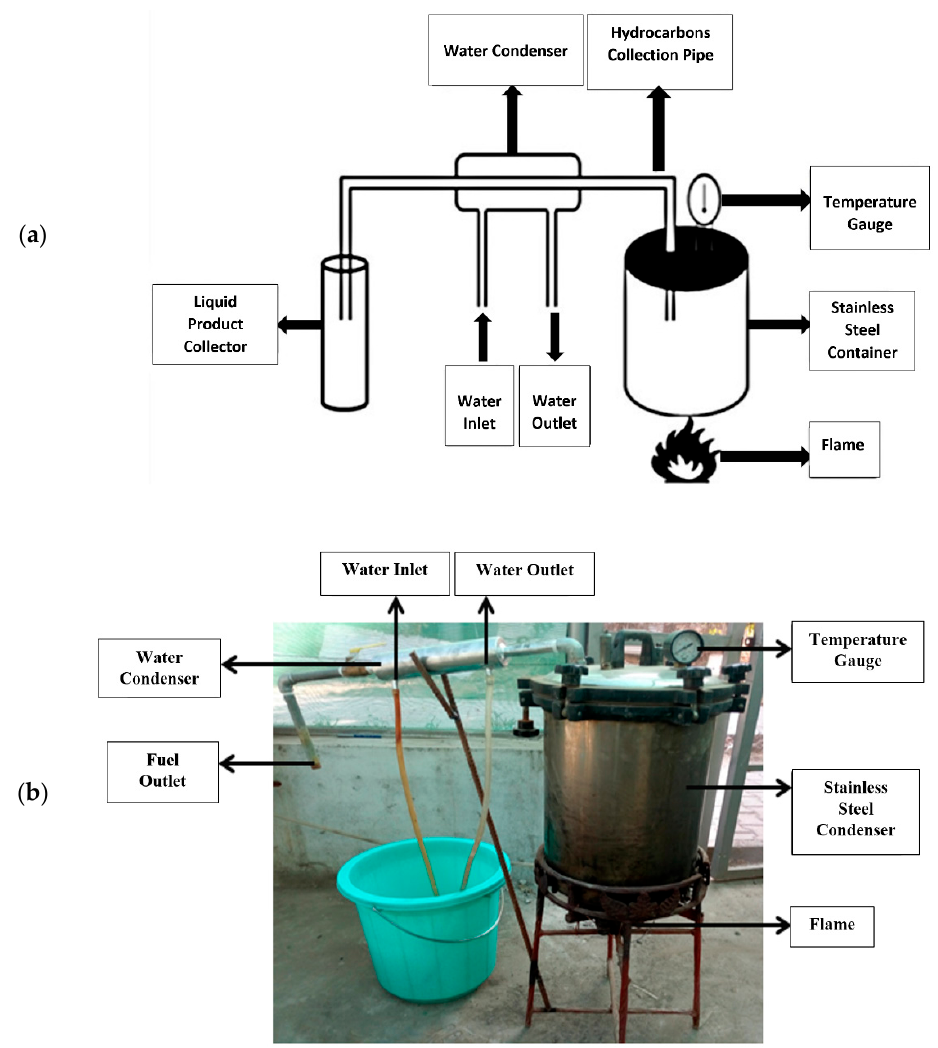
Figure 1. The pyrolysis set-up used in the study. ( a ) Schematic representation. ( b ) A photograph of the equipment for the conversion of plastics into fuel.